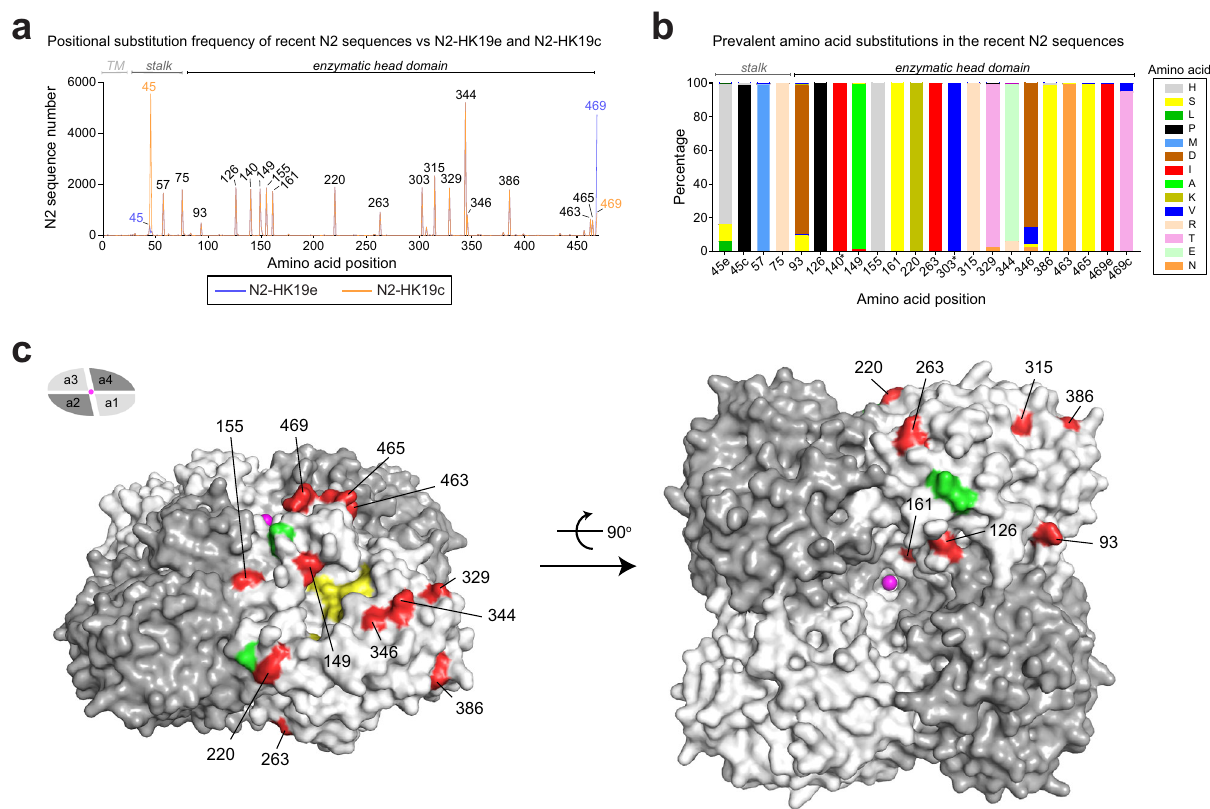
Fig. 6 Comparison of NAs from recent H3N2 viruses and the 2020 – 2021 vaccine strains. a Amino acid positional analysis displaying the number of recent N2 sequences that encode amino acids which differ from N2-HK19c (orange) and N2-HK19e (blue) at each position. N2 sequences were from human H3N2 IAVs isolated between September 1, 2019 and December 15, 2020. Amino acid positions corresponding to the TM domain, stalk and enzymatic head are indicated. b Bar graph displaying the prevalence of the amino acids in recent N2 sequences that differ from N2-HK19e and N2-HK19c at each position. Note N2-HK19e and N2-HK19c differ at positions 45 and 469. Only amino acids visible in the graph are listed. Asterisk indicates amino acids with little surface exposure. c Amino acid positions that differ in recent N2 sequences were highlighted (red) on a single monomer of a head domain tetramer (PDB ID: 4GZT) 55 . Asn residues (green) of the conserved N-linked glycosylation sites 48 , NA active site residues (yellow), and Ca 2 + ions (pink) are also depicted. Positions 140 and 303 are not visible. Side (left) and bottom (right) views of the NA tetramer were generated using